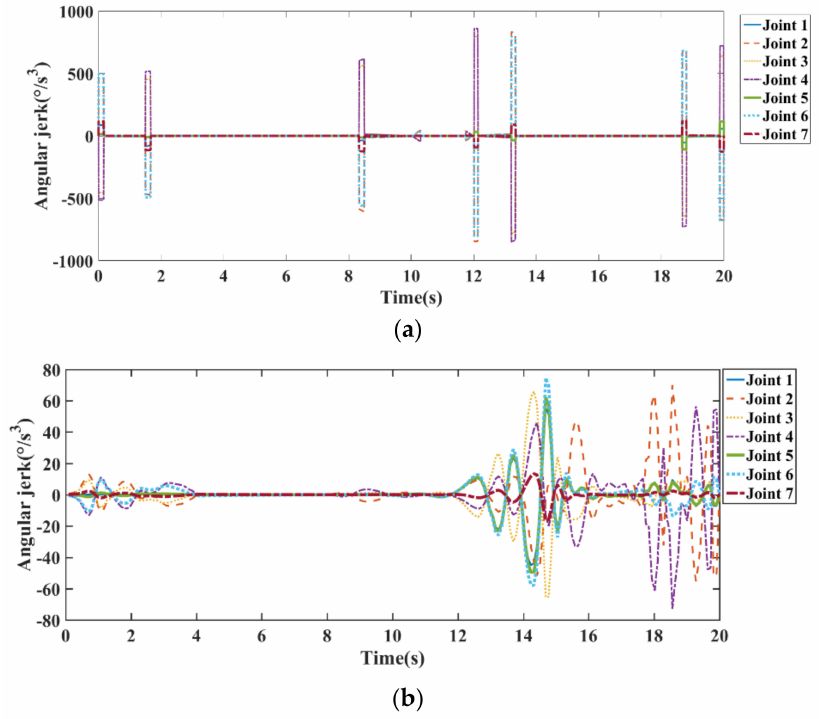
Figure 12. Joint angular jerk of trajectories. ( a ) Without optimization, ( b ) With